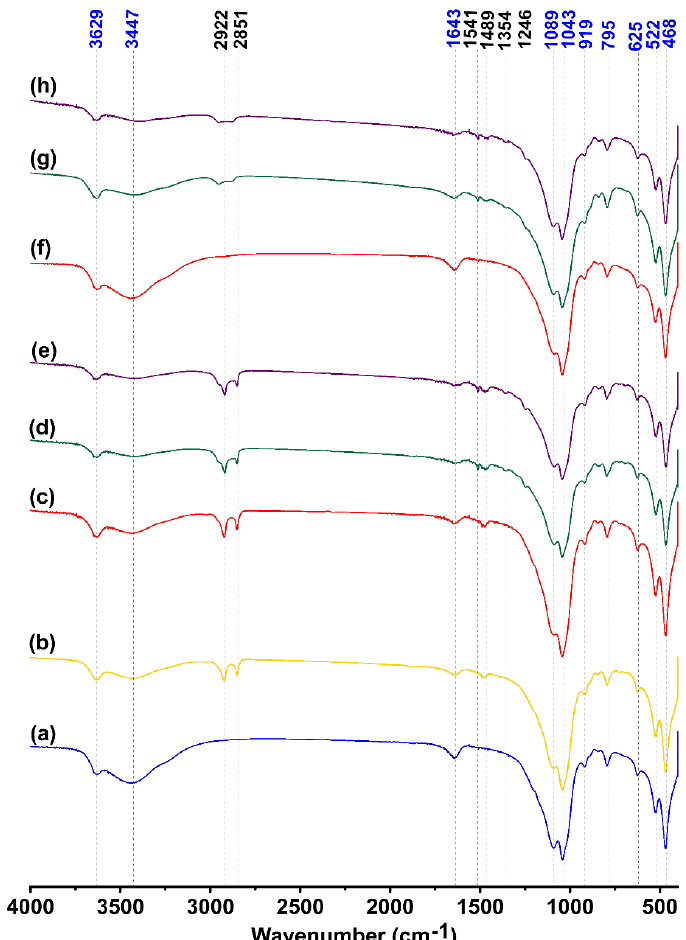
Figure 3. Fourier transform infrared (FTIR) spectra of: ( a ) BENT, ( b ) HD-B, ( c ) HD-TX-2, ( d ) HD-TX- 48, ( e ) HD-TX-120, ( f ) TX-2, ( g ) TX-48, and ( h ) TX-120 (blue values—bands derived from natural bentonite; black values—bands that appear after adsorption of the surfactants).